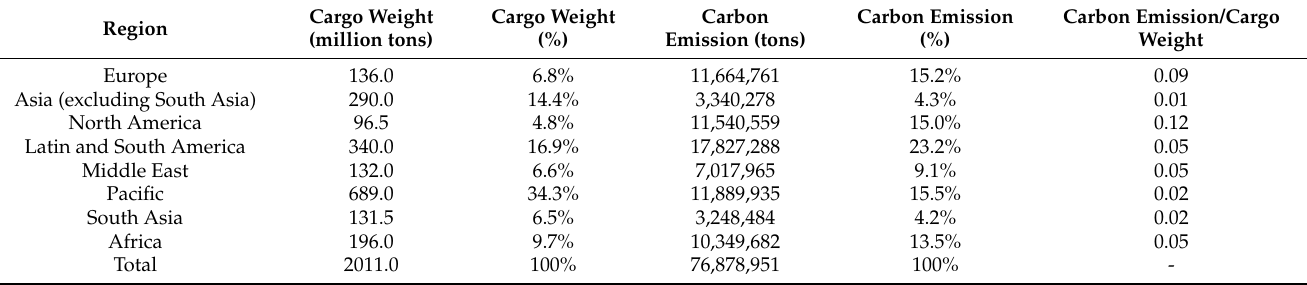
Table 2. Estimated carbon emissions from dry bulk shipping trade in China, 2021. Cargo Weight Region (million